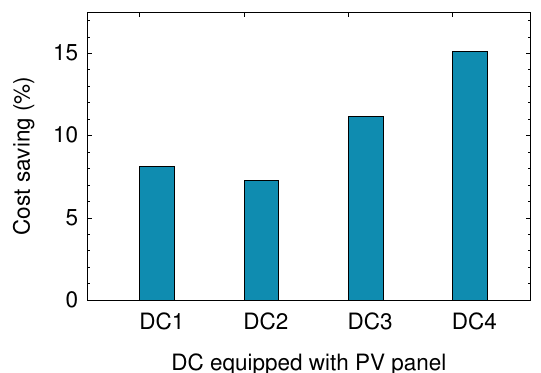
Figure 11. Cost-saving achieved by installing the PV panels in one DC only.